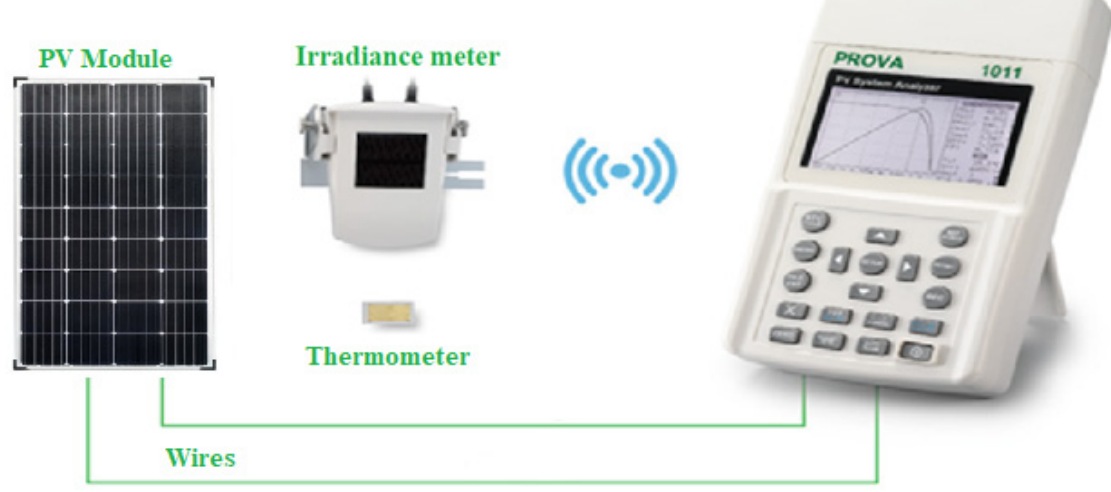
Figure 2. Set-up for extracting IV curves by Prova 1011 solar system analyzer. An IV curve can represent the relationship between the current (the vertical axis of the curve) and voltage (the horizontal axis of the curve) at a specific irradiance and tem- perature, as shown in Figure 3. Analyzing the figure shows several essential points in the IV curve. As shown in Equation (1), the I sc represents the highest current produced when the voltage is zero. I (at V = 0) = I (cid:2929)(cid:2913) V (at I = 0) = V (cid:2925)(cid:2913)